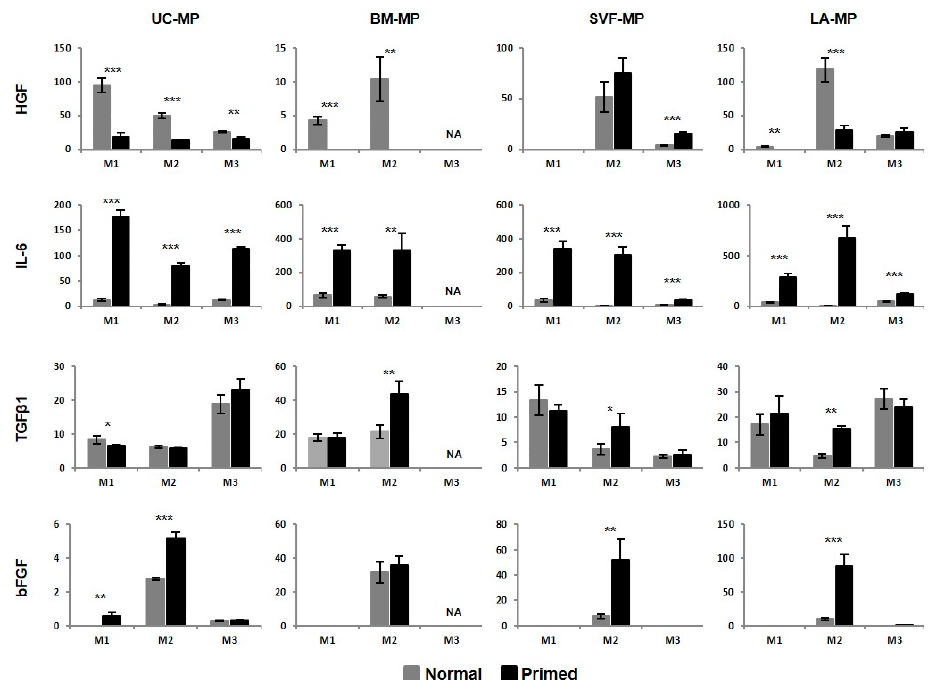
Figure 7. Paracrine activity of tissue-specific MSC-based MPs. Cytokine secretion in normal